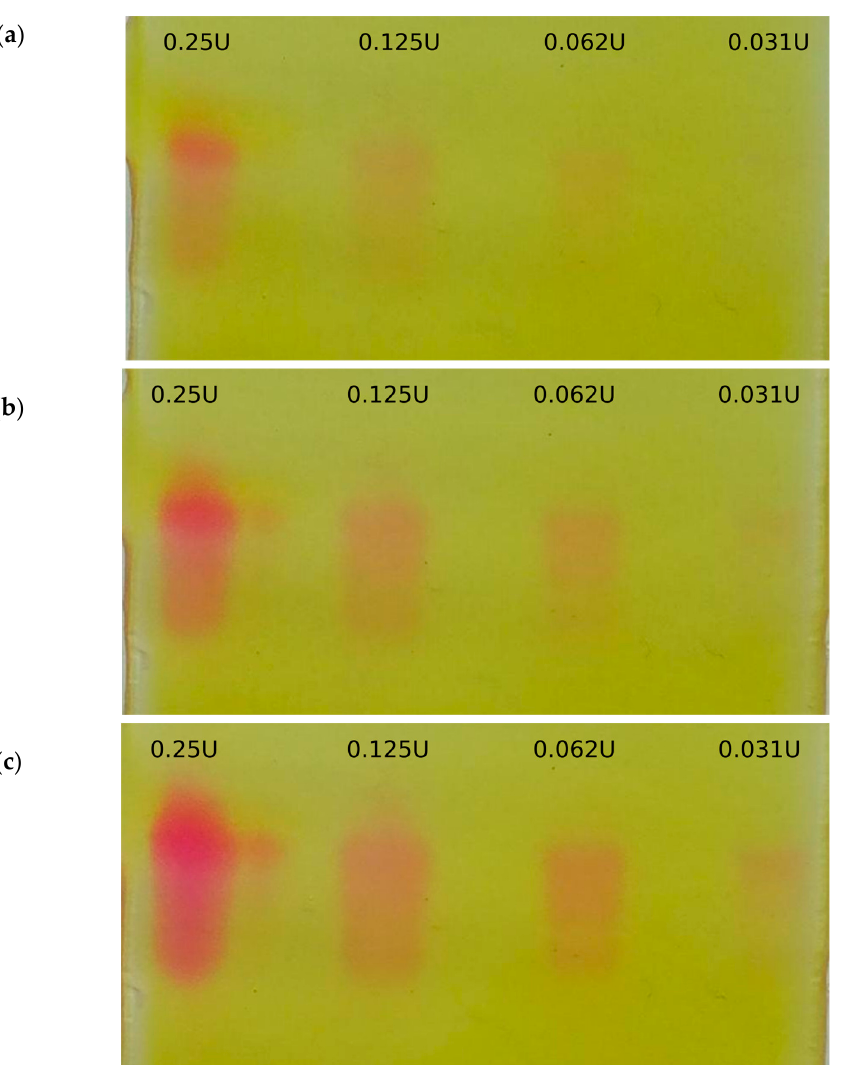
Figure 2. Short-term time course of the detectable on-gel signal—a serial dilution of myrosinase standard was detected with the proposed detection reagent containing sinigrin, 6 mM; ascorbic acid, 1 mM; Na 2 HPO 4 , 1 mM; pH 7.5; methyl red, 100 µ g mL − 1 . 0.031–0.25 enzyme units (U) of Sinapis alba thioglucosidase (myrosinase) standard) was separated on 7.5% native PAGE. Subplots: ( a ) 4 min, ( b ) 6 min, ( c ) 8 min.